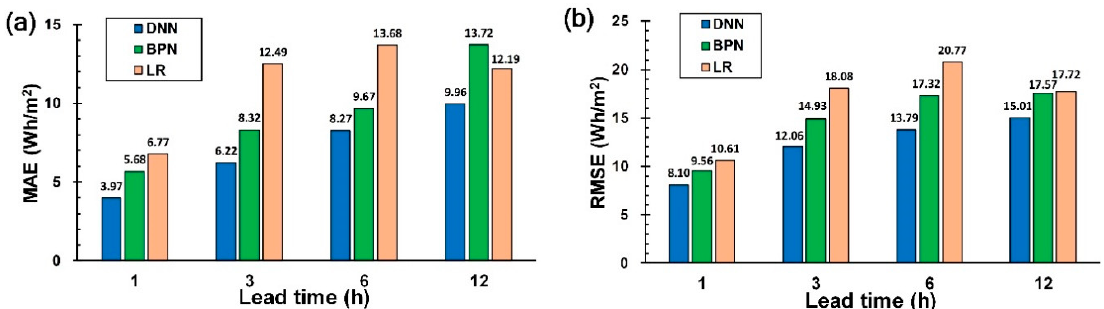
Figure 10. Annual performance of predicted power outputs of module BP3125: ( a ) MAE and ( b ) RMSE.